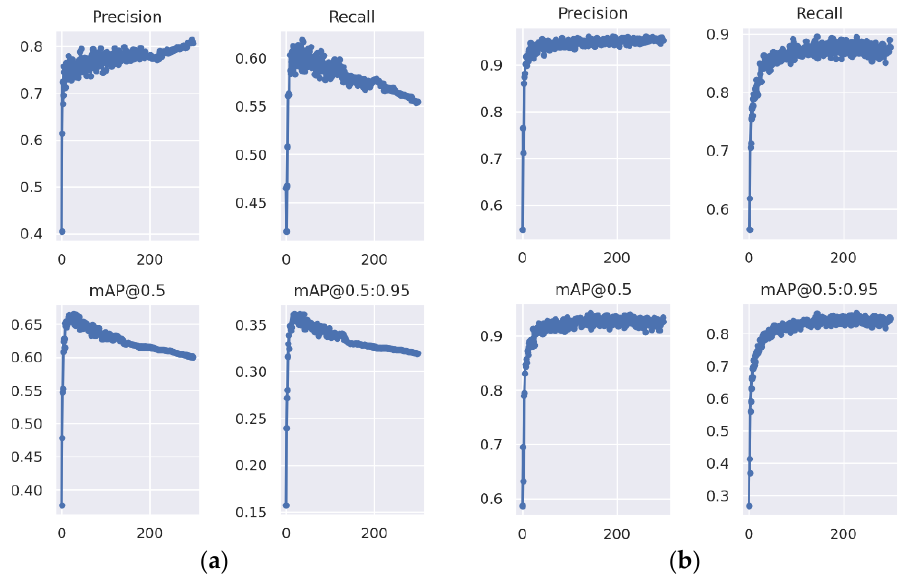
Figure 14. The performance of the model in the test set when trained with and without random expansion of small objects: ( a ) the performance of the model trained without random expansion; and ( b ) the performance of the model trained with random expansion.